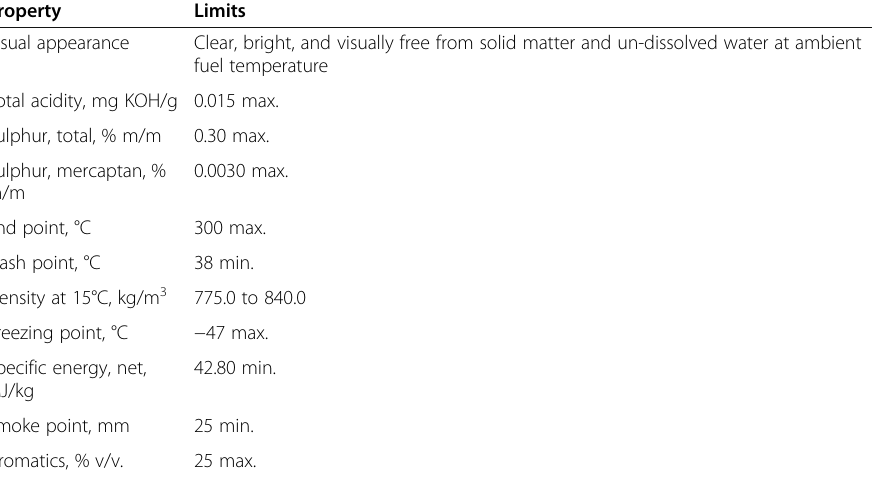
Table 1 Standard specifications for kerosene-type aviation turbine fuel (Jet A-1) [3 – 5]